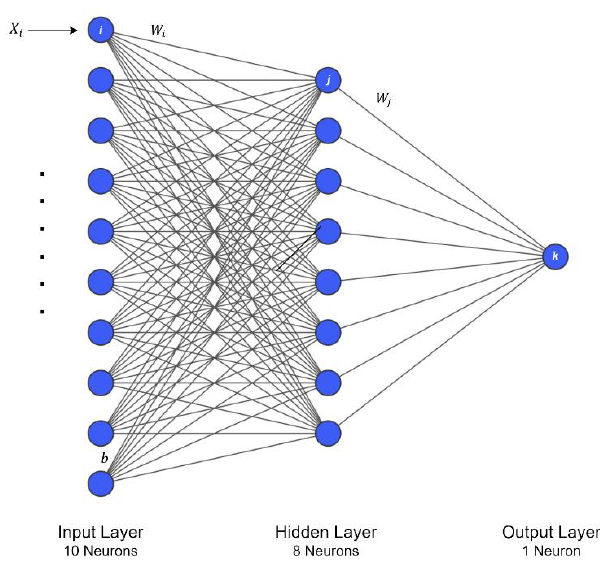
Figure 6. Artificial neural